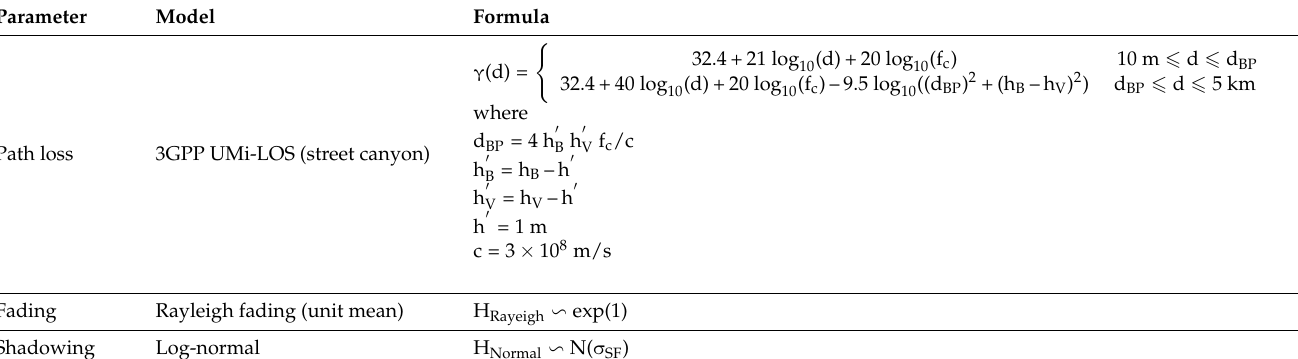
Table 4. The parameters used in the propagation channel model.